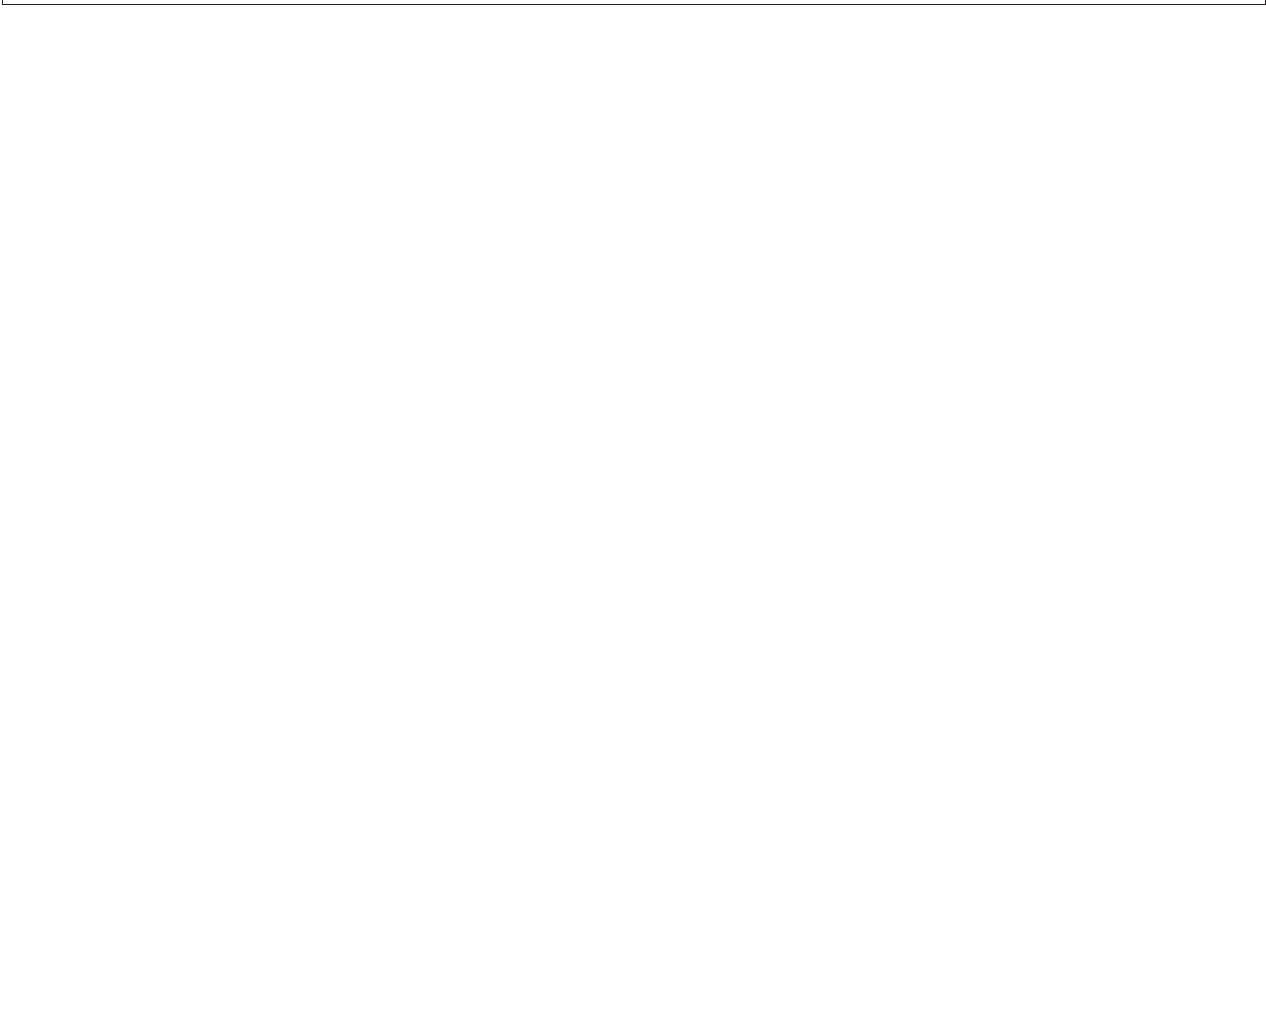
Frontiers in Sustainability |